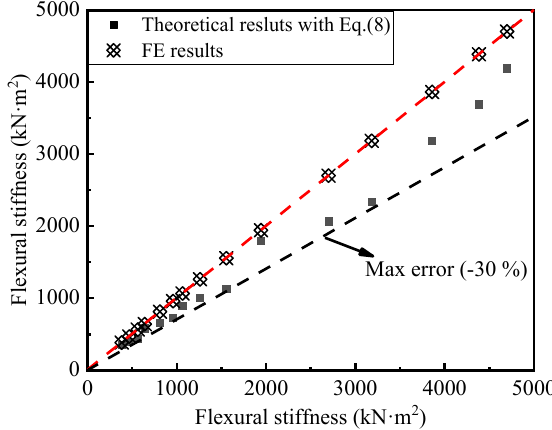
Figure 23. Comparison of the flexural stiffnesses.